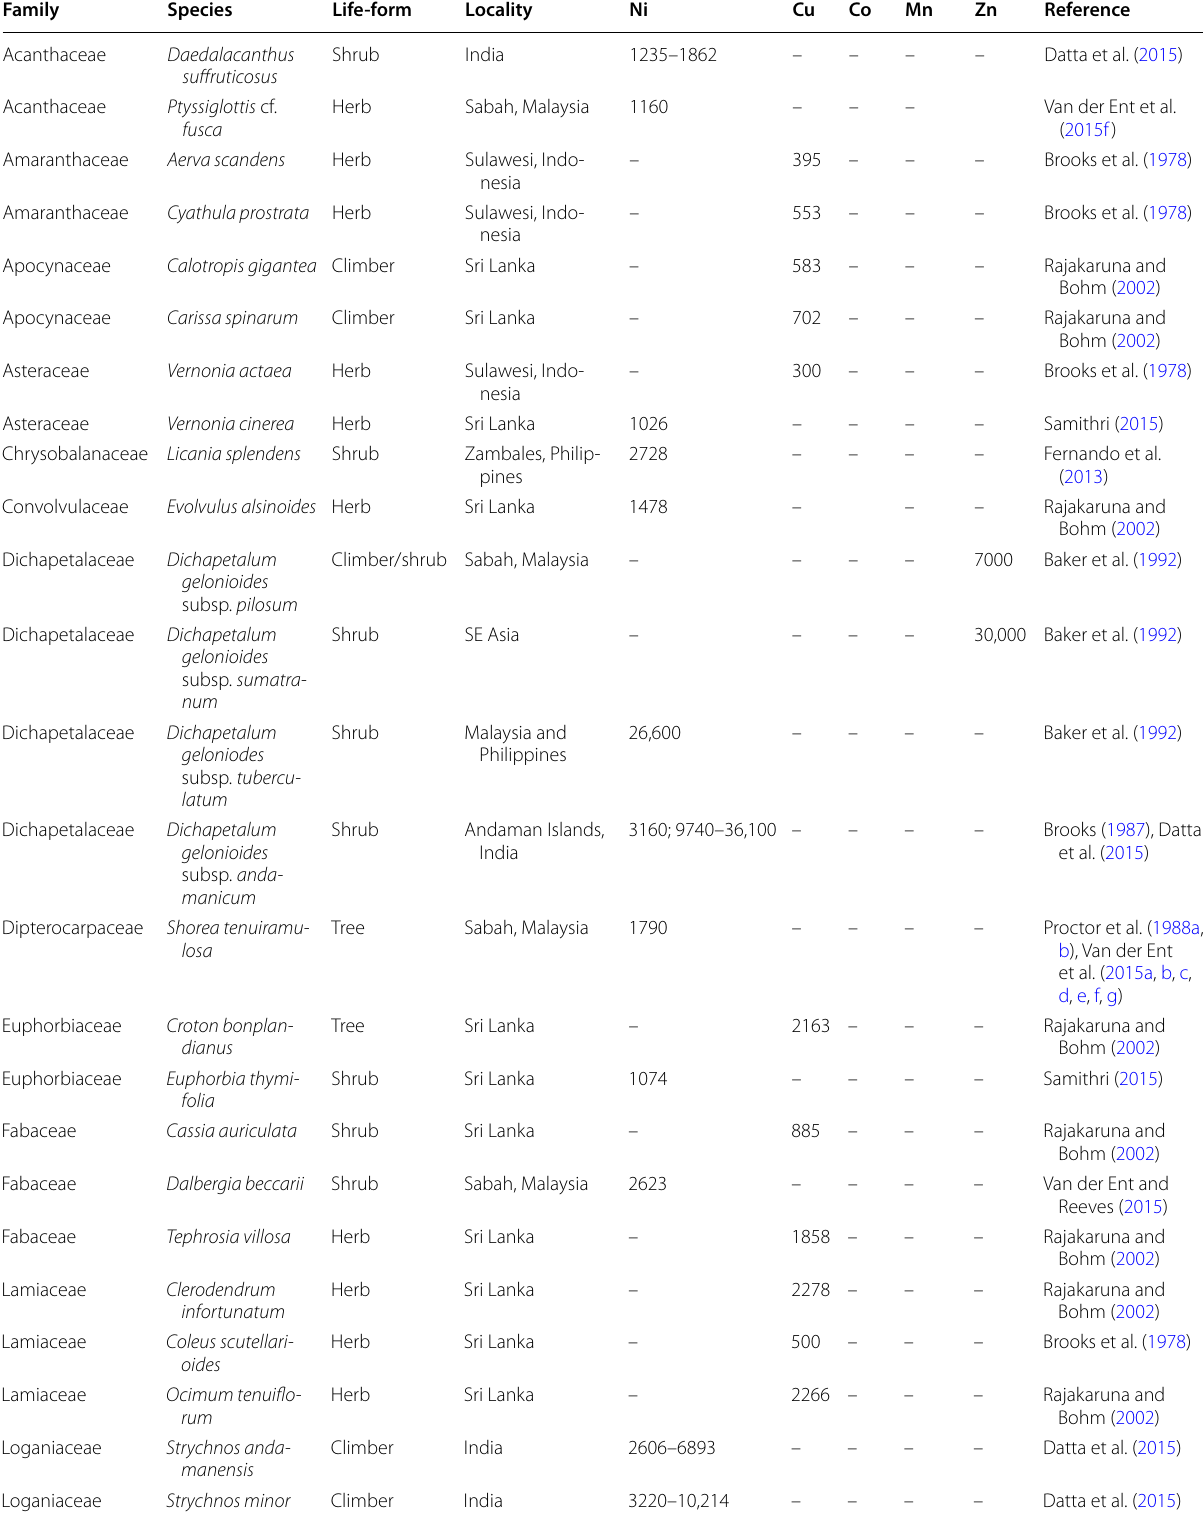
Table 4 Unusual foliar elemental accumulation (Ni, Co, Cu, Mn or Zn—maximum recorded values in μg g − 1 ) in plants from South and Southeast